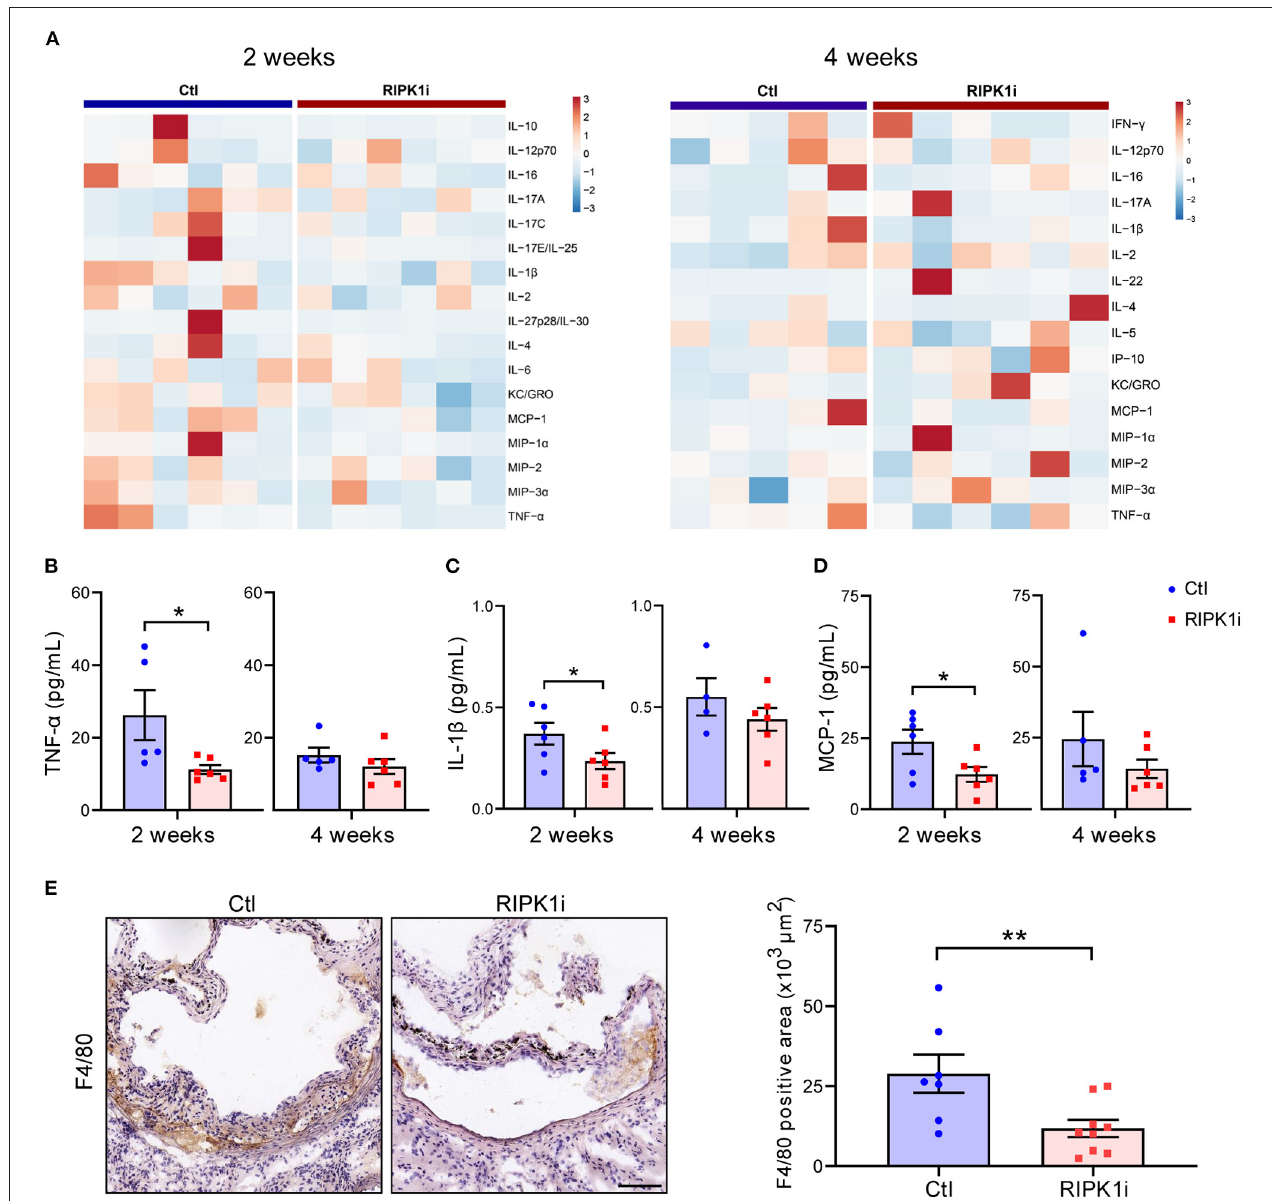
FIGURE 6 | RIPK1i treatment alleviated systemic inflammation and macrophage infiltration in early atherogenesis. (A) Heat map analysis of inflammatory cytokines levels in ApoE SA / SA mice in early stage (left, 2 weeks) and late stage (right, 4 weeks). (B–D) Plasma levels of TNF- α (B) , IL-1 β (C) and MCP-1 (D) in early stage (2 weeks) and late stage (4 weeks) of ApoE SA / SA mice. n = 4–6 mice per group. (E) Representative IHC images of F4/80 in aortic sinus plaque from ApoE SA / SA mice in early stage (left). Quantification of macrophages (F4/80 positive) are represented (right). Scale bar = 100 µ m. n = 7.9 mice per group. All of the data represented as mean ± SEM; * P < 0.05; ** P < 0.01. Statistical analysis: non-parametric Mann-Whitney U test (B,E) , unpaired student’s t -test (C,D)